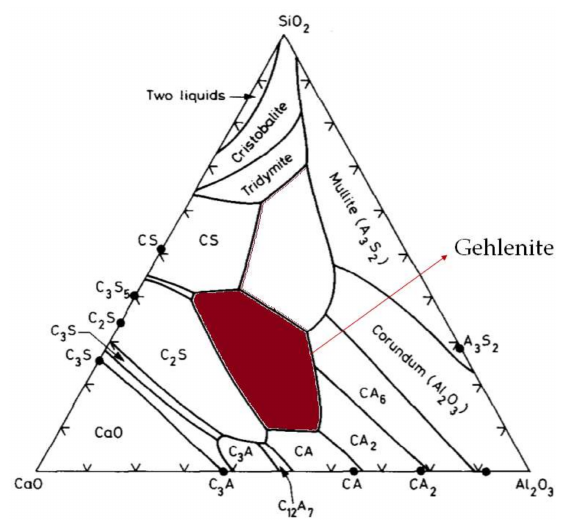
Figure 3. Ternary phase diagram of Al 2 O 3 -CaO-SiO 2 . Brown: gehlenite.